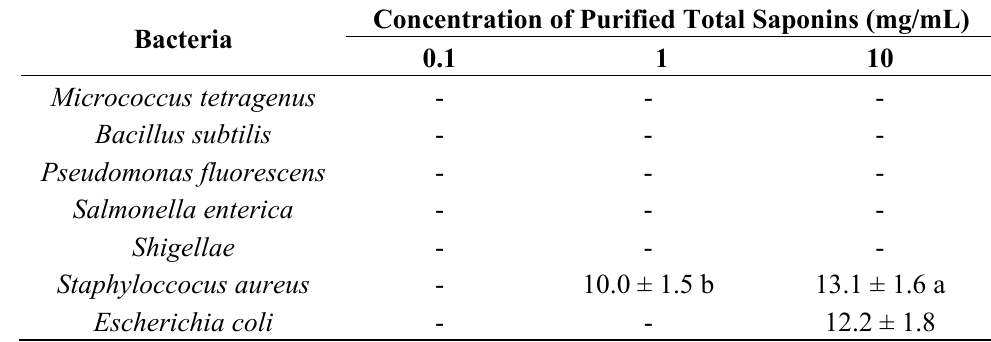
Means ( n = 3) ± SD followed by different letters (a, b and c) indicated significantly different scores in the